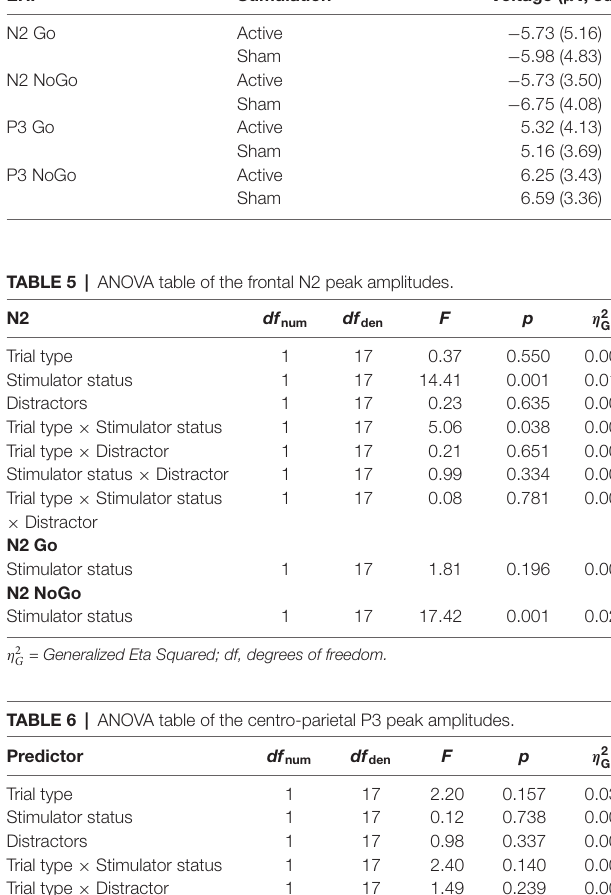
TABLE 4 | Mean amplitude ( µ V) and standard deviation of frontal N2 and centro-parietal P3 peaks during active and sham stimulation. ERP